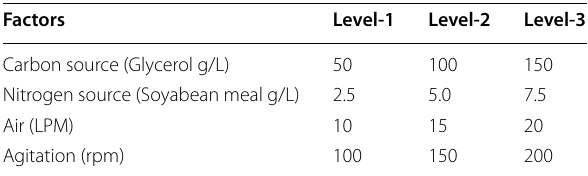
Table 1 Assignment of factors and levels of the orthogonal array design L9 for optimization of biomass (DCW) and setomimycin production by Streptomyces sp.